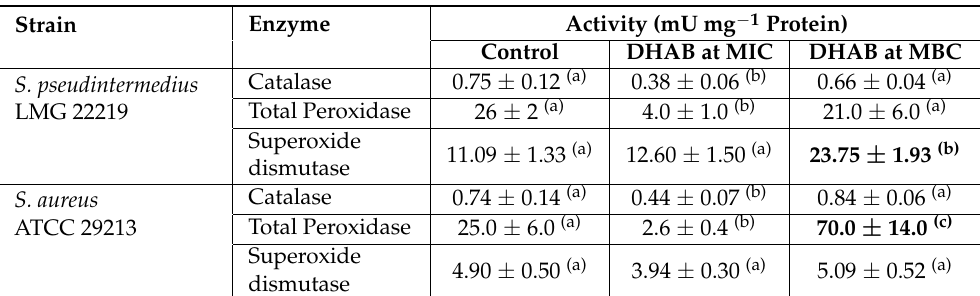
Table 4. Determination of ROS-scavenging enzymes in S. pseudintermedius and S. aureus in the presence of DHAB at concentrations 1 × MIC and 1 × MBC. Data are means ± standard deviations of three independent determinations in two independent cultures. Significant differences at p < 0.05 are indicated by different letters ( a, b, c ). Data in bold correspond to significant